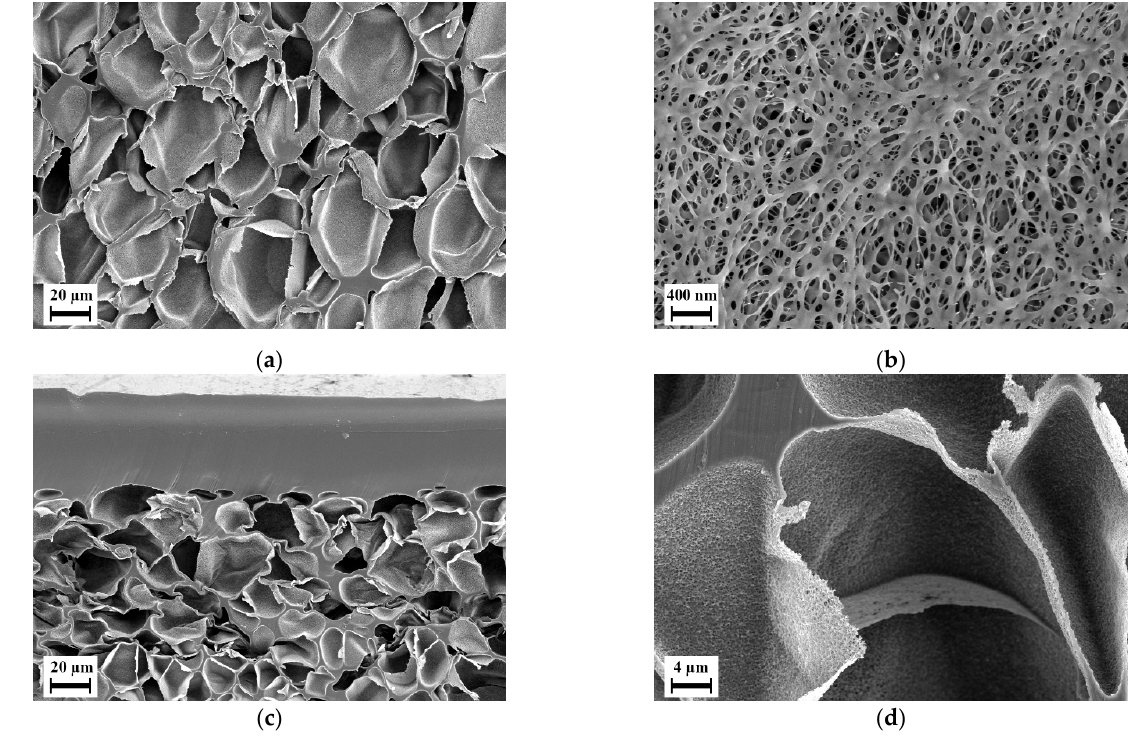
Figure 8. Scanning electron micrographs of foams manufactured using blowing agent CO 2 and H 2 O at loading time 48 h, pressure 100 bar, loading temperature 150 °C, foaming time 100 s and foaming temperature 230 °C for Blend H-8: ( a ) internal structure at 500× magnification; ( b ) internal structure at 20,000× magnification; ( c ) structure near the surface at 500× magnification; ( d ) internal structure at 2500× magnification.